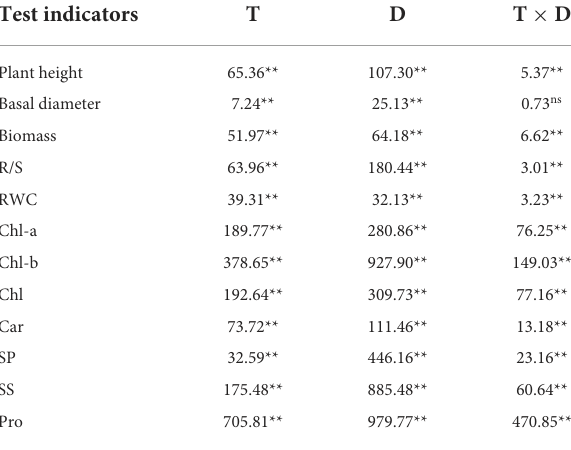
TABLE 1 F-values from two-way ANOVA for soil water treatment (T) and treatment duration (D) among morphological and physiological indexes of A. selengensis